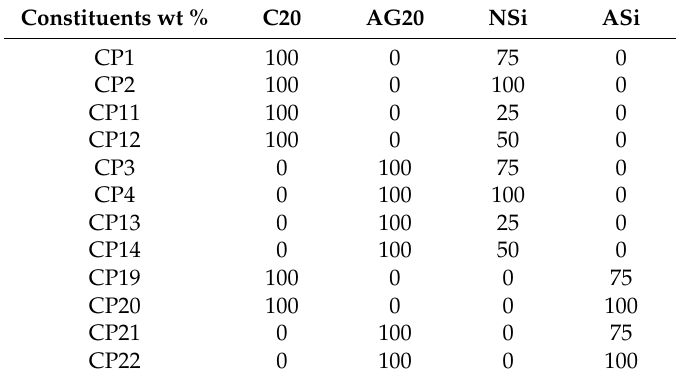
Table 1. Composition and labelling of composites prepared from cellulose matrix. Constituents wt % C20 AG20